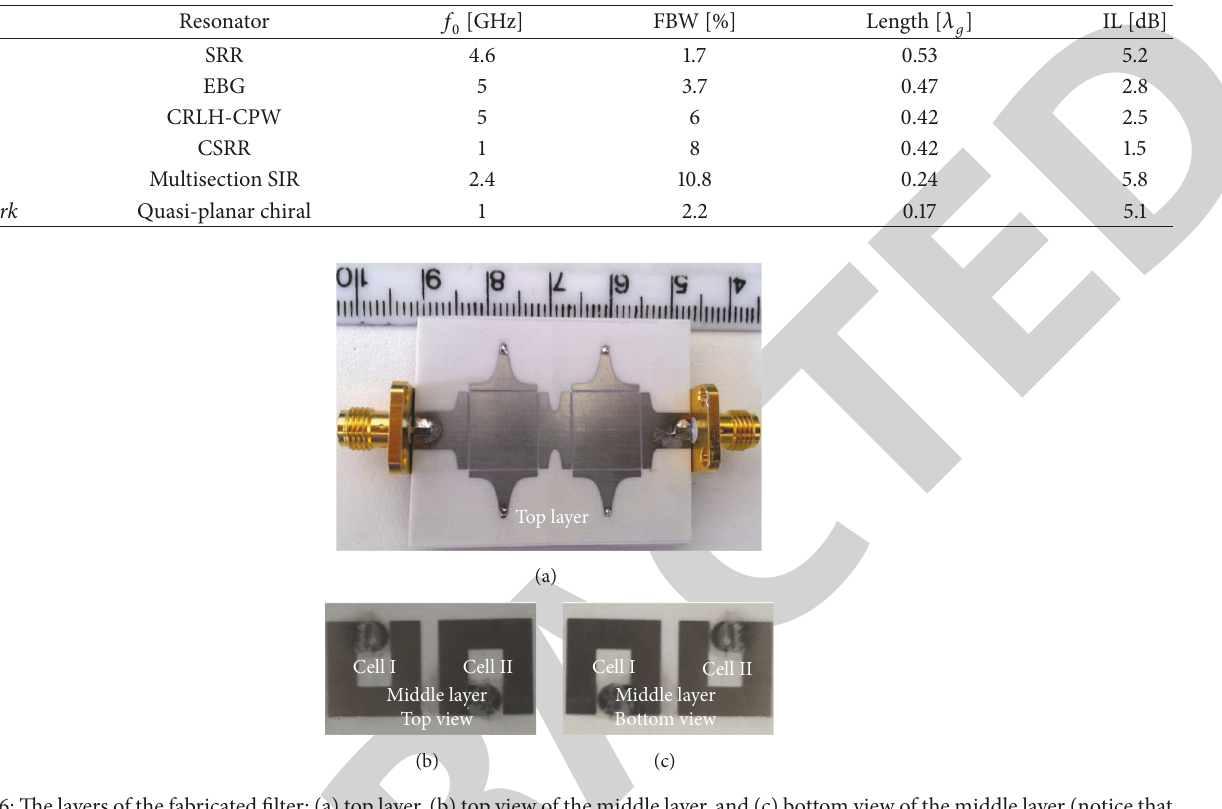
Figure 6: The layers of the fabricated filter: (a) top layer, (b) top view of the middle layer, and (c) bottom view of the middle layer (notice that the bottom layer (not shown in this figure) is ground